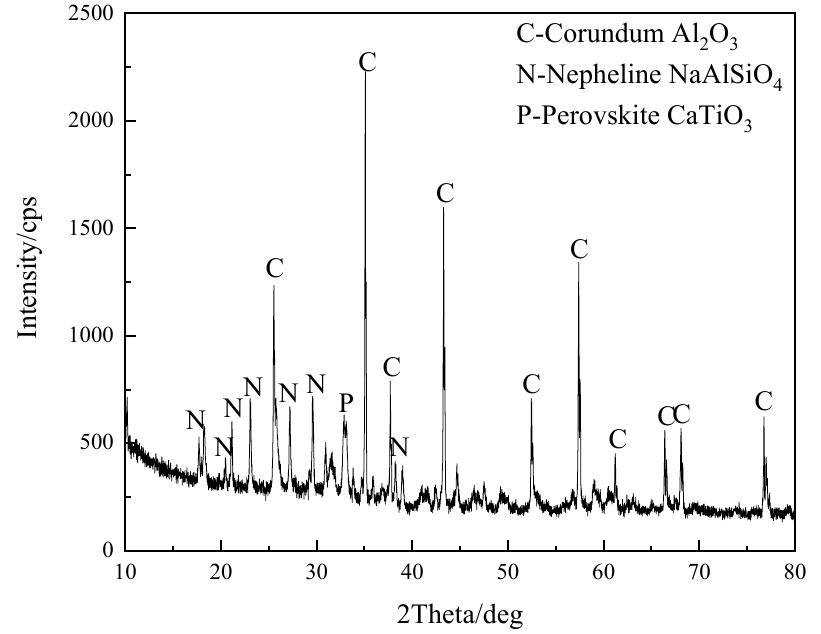
Figure 1. XRD pattern of the SSS. Table 2. Main chemical composition of SSS (%).